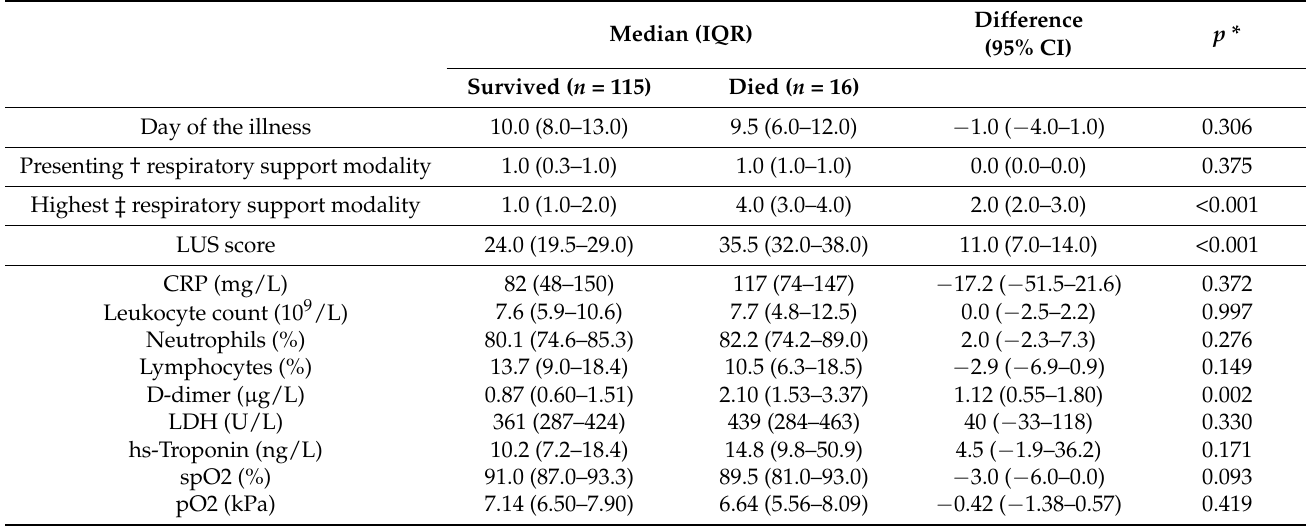
Table 4. Differences in indicators according to